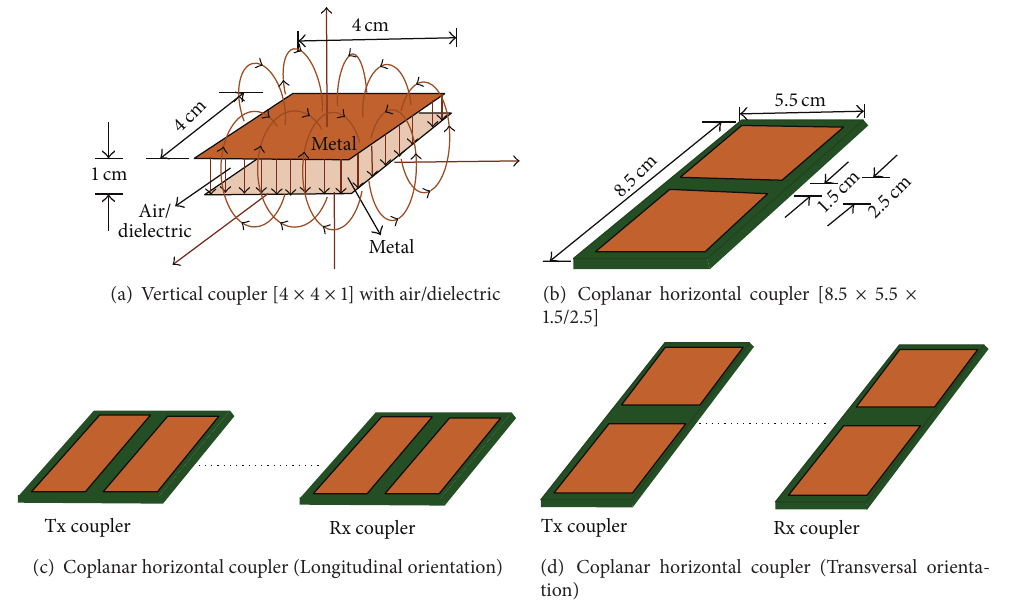
Figure 1: Coupler configurations and their